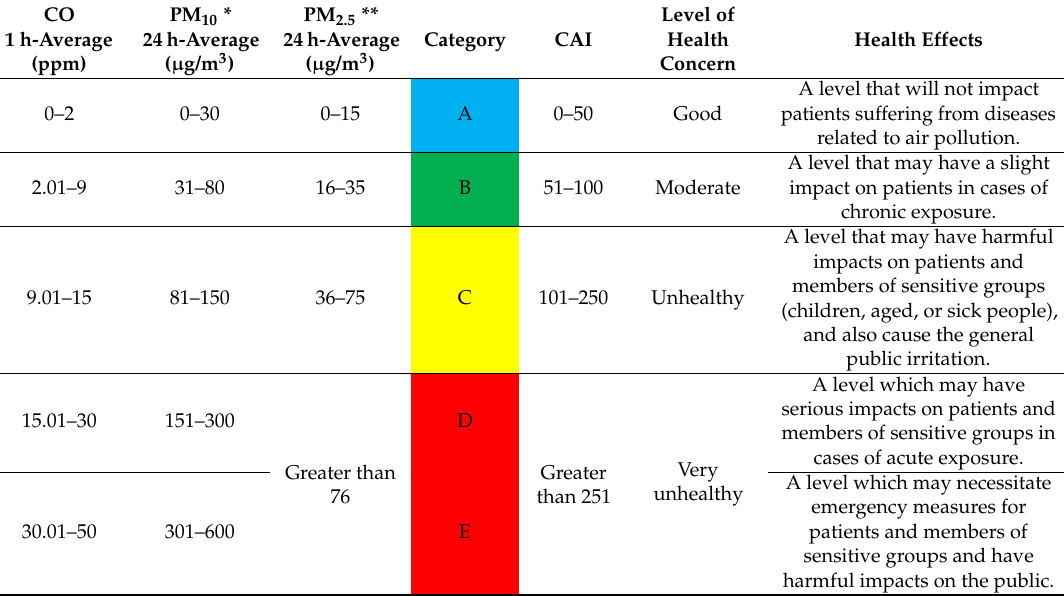
Table 3. Description of the comprehensive air quality index